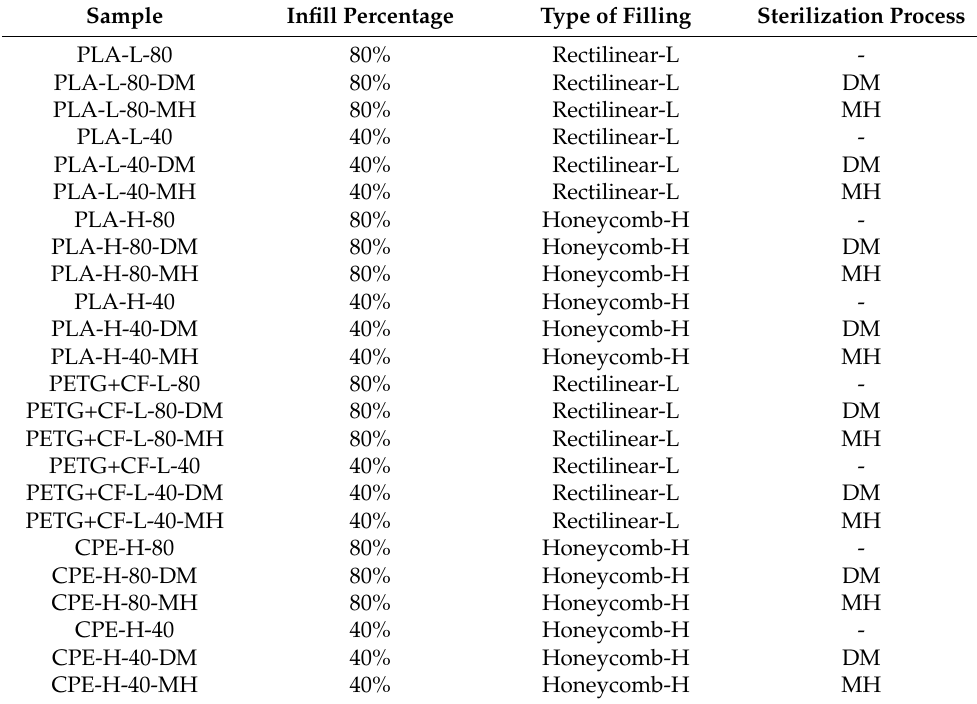
Table 1. Designation of each printed sample in this study, the sterilization process used, as well as the type and the Infill percentage